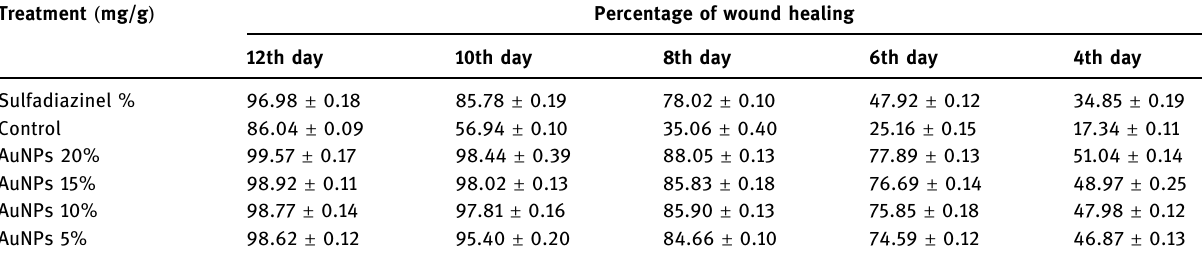
Table 2: E ff ect of AuNPs on wound contraction in thermal wound model Treatment ( mg/g )